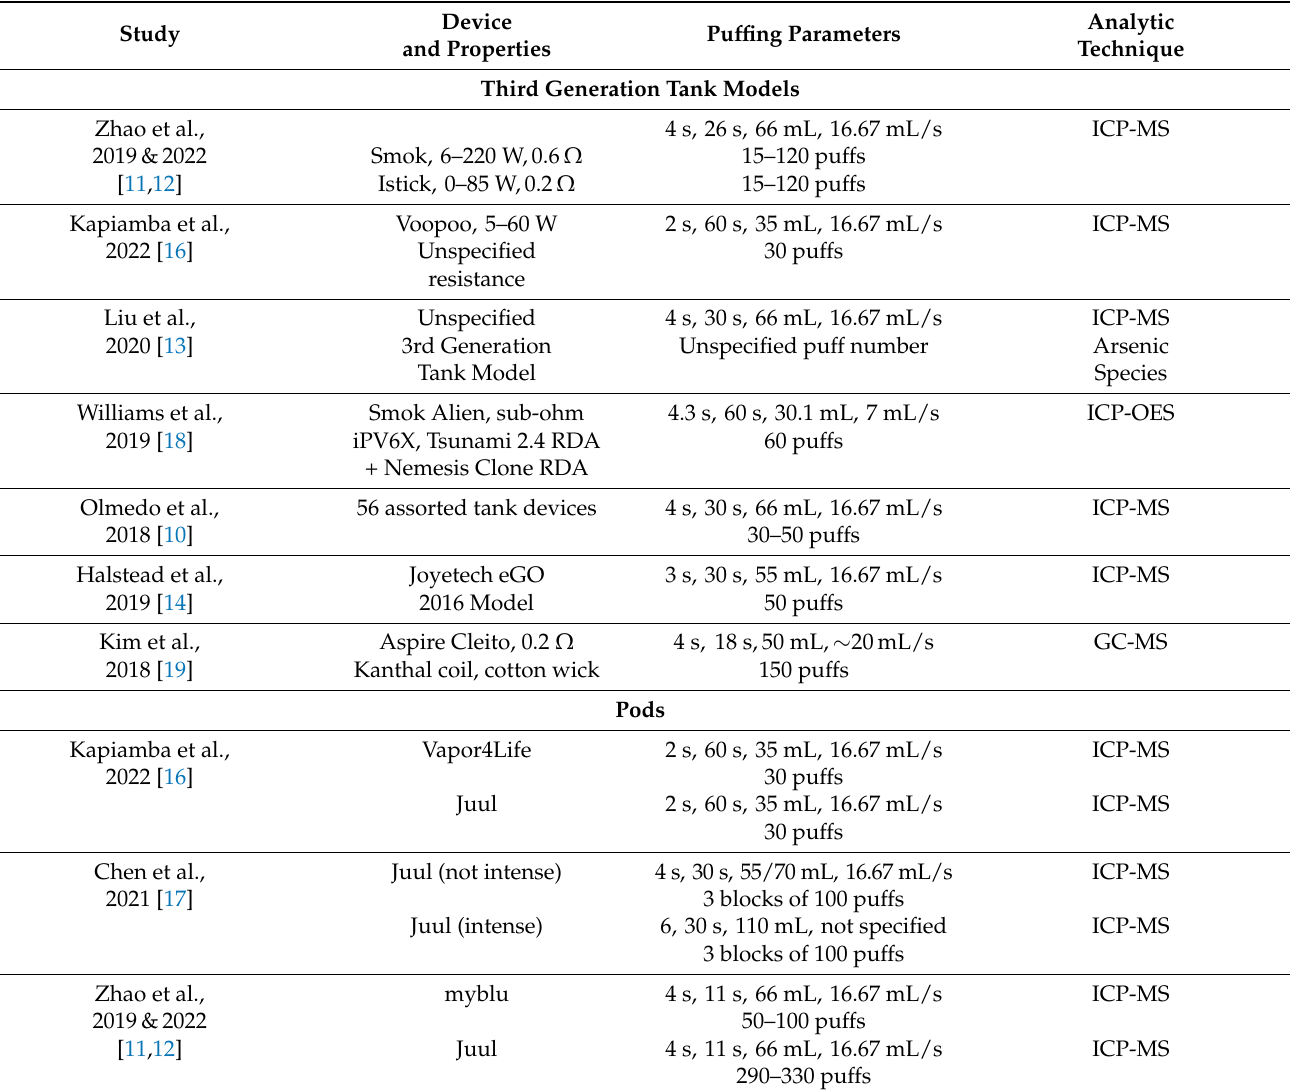
Table 3. Laboratory studies on metal content in aerosol emissions published after 2017. The